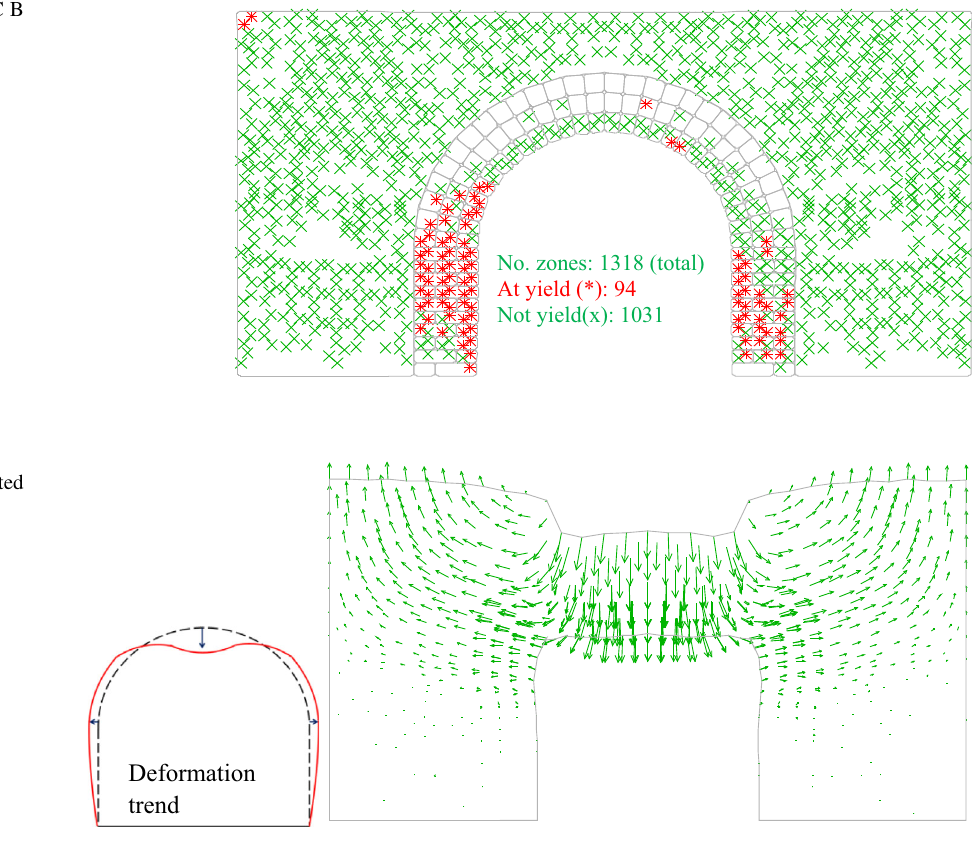
Fig. 7 Failure state of UDEC B under uniform load ( H = 1075 mm)